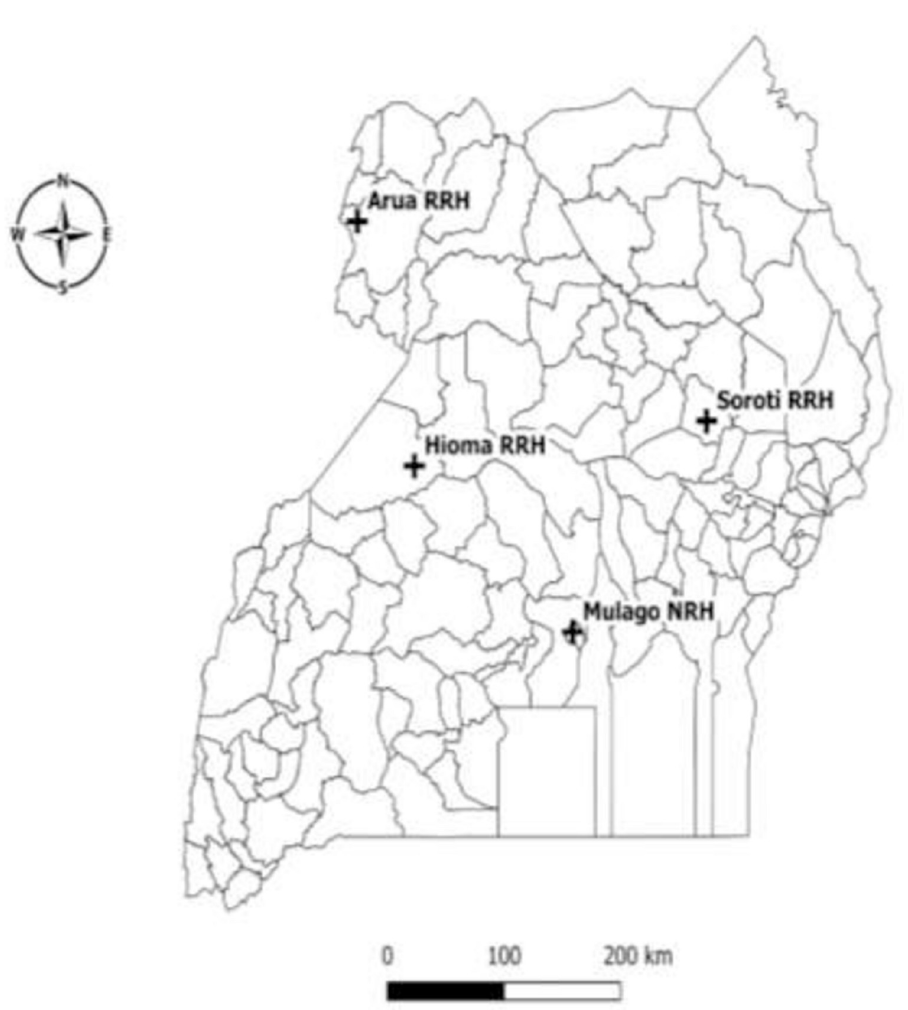
Fig 1. A map of Uganda showing regional distribution of tertiary referral hospitals during study implementation. Link; https://data.humdata.org/dataset/uganda-administrative-boundaries-admin-1-admin-3.